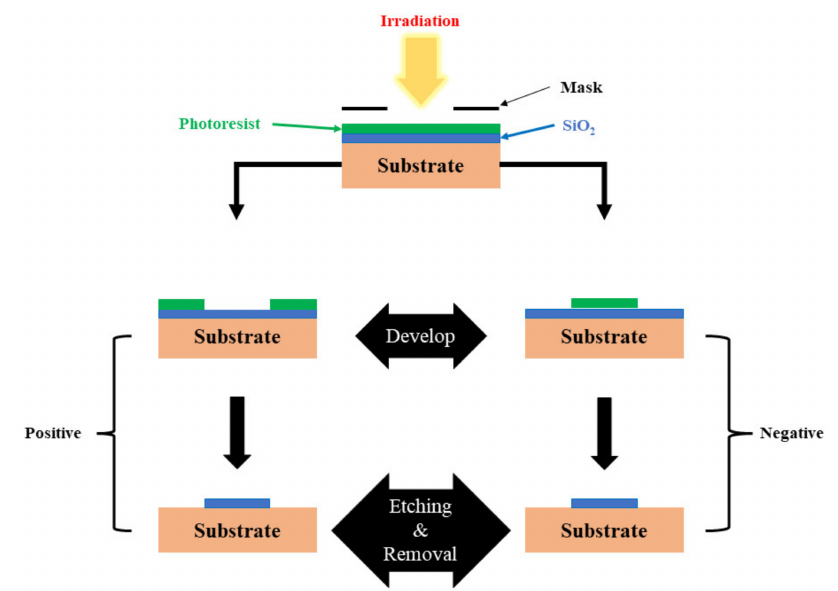
Figure 3. Types of